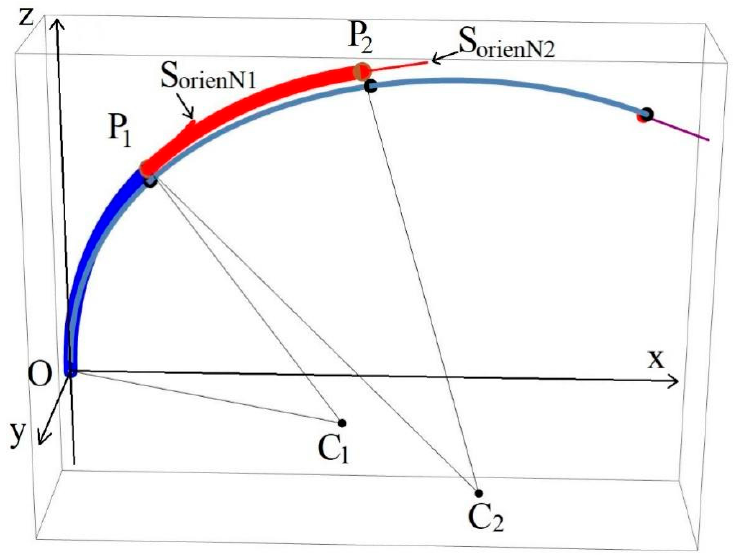
Figure 13. Second segment endpoint P 2 and orientation vector s orienN2 in second segment’s coordination system.